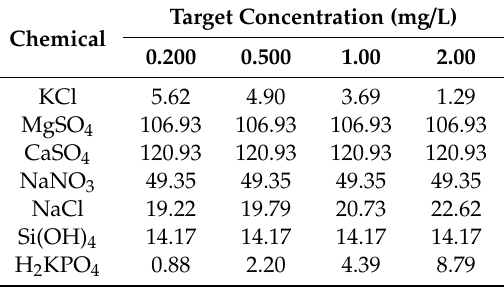
Table 3. Chemical compound concentration in the synthetic subsurface drainage formulation. Target Concentration (mg / Chemical